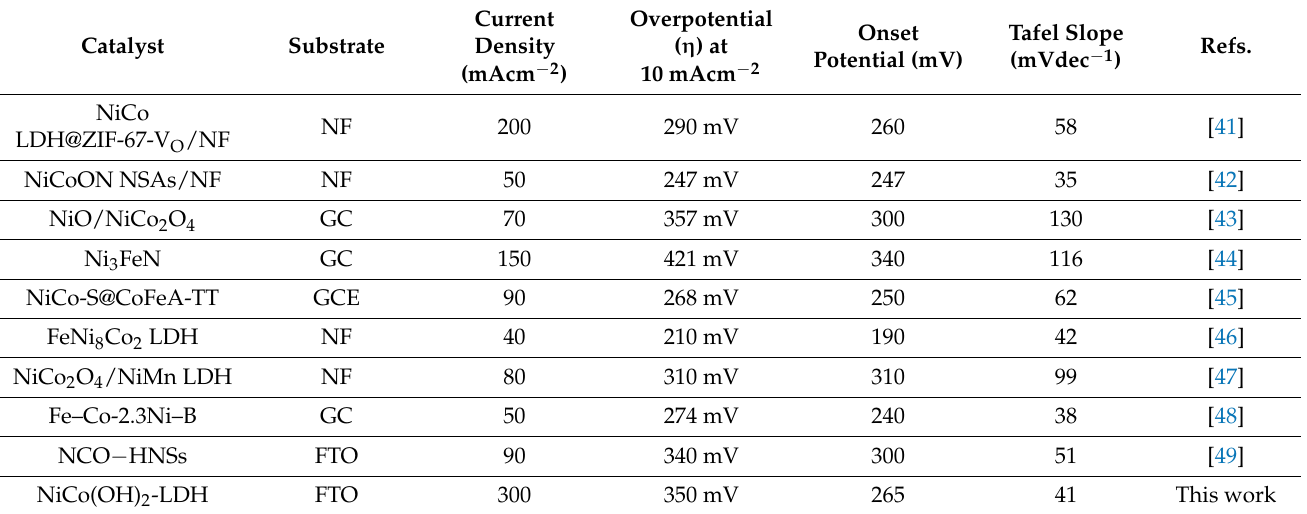
Table 1. Comparison of the OER performance parameters of our synthesized and reported Ni- and Co-based electrocatalysts.